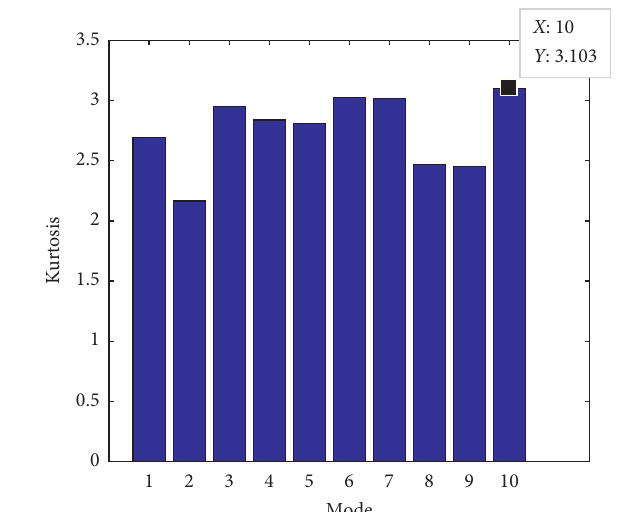
Figure 12: Kurtosis values of each